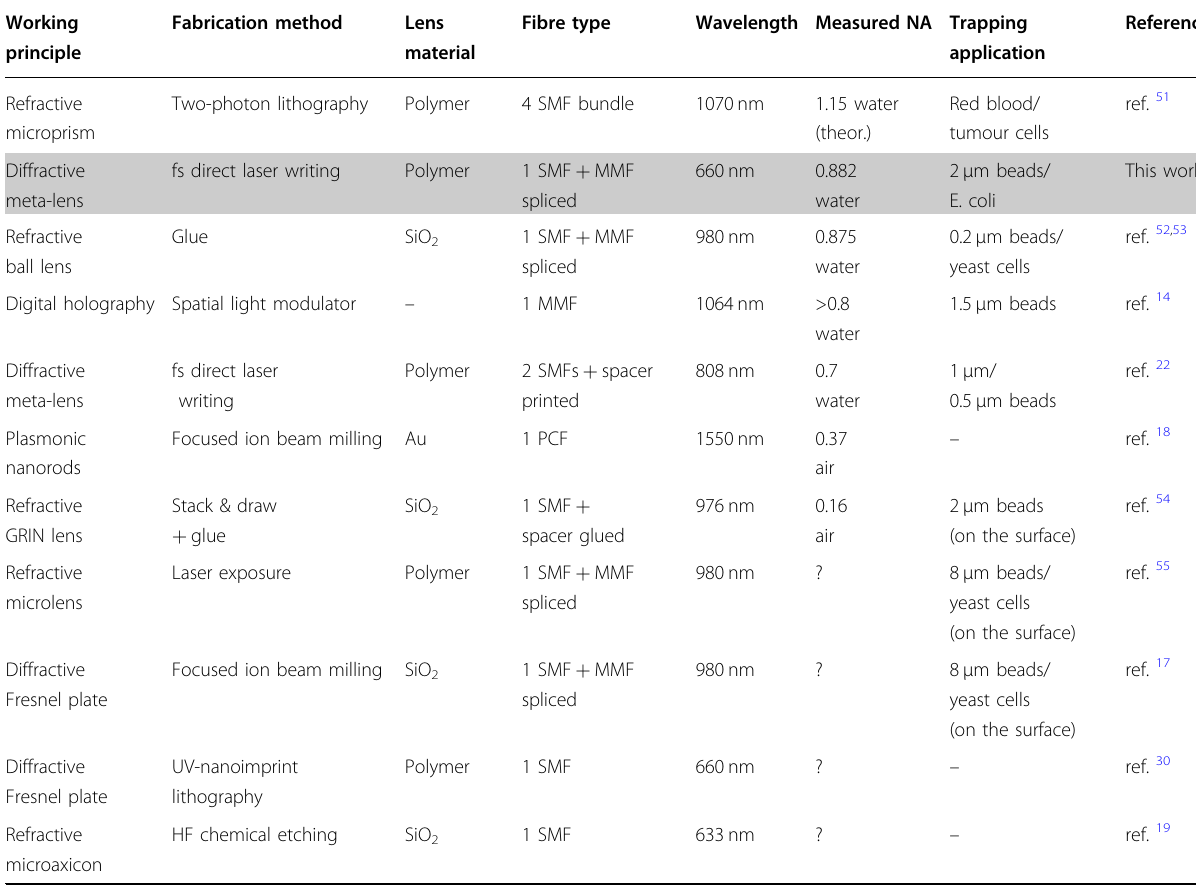
Table 1 Summary of the previously reported work